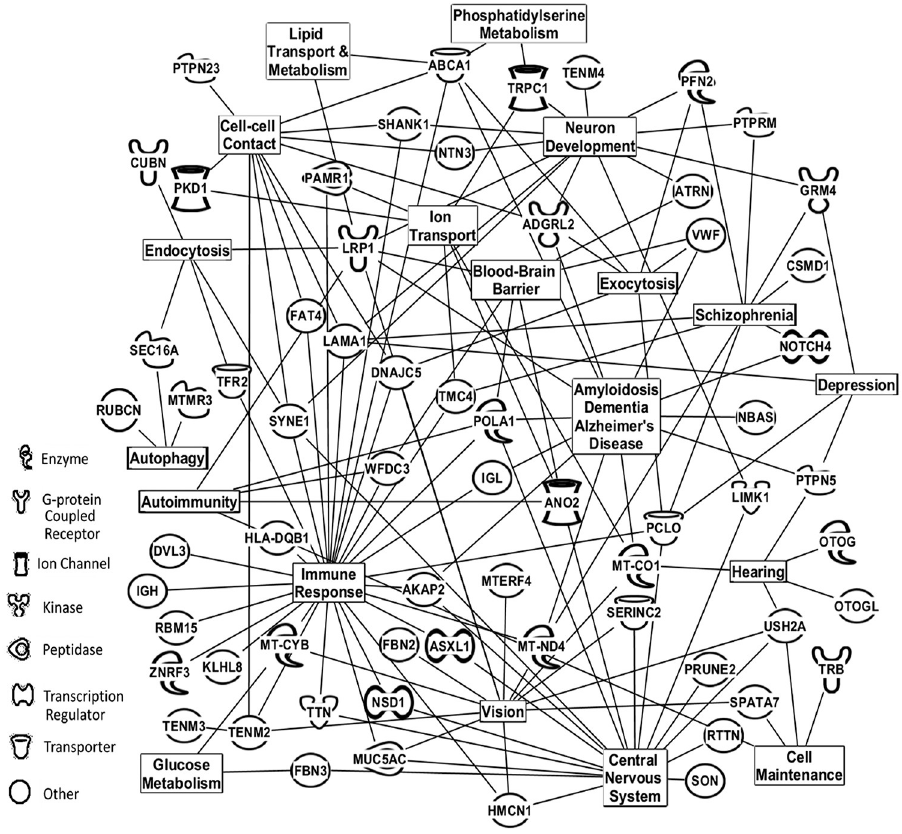
Fig 6. Physiological/cellular pathways of serum proteins found to distinguish TBI most affected patients from controls. Affected physiological/cellular pathways and serum protein assignments from Table 3 (top panel) that were found to distinguish TBI most affected patients from control individuals. The next top 58 proteins for each group (TBI most affected or control) not exhibited in Table 3 were added to the 48 in this table for this analysis. Analysis performed by using Ingenuity Pathway Analysis (IPA) bioinformatics software (Qiagen, Inc.). peak comparison dataset (e.g., peak 635, Fig 2 panel B). This midpoint is used to assign the group LOOCV classification for any “left out” peak in the LOOCV analysis. For example, if a “left out” samples identical m/Z peak has an area above this midpoint then that peak is classi- fied as the larger peak area class. In the case of peak 635 this would be the most affected classifi- cation; if the area is equal to or below this value the peak classification would be “control”. In this way a % of significantly changed mass peaks classified (e.g., as most affected) is assigned each “left out” sample and plotted on the y axis vs the individual serum samples on the x-axis (e.g., in Fig 3 panel A). Randomization of serum samples from subject groups compared in binary fashion (another method to assess data over-fitting) was obtained using the RAND function in Excel 2016 but retaining group number and age ratios [31]. Upon randomization, the identical mass peak LOOCV database was created and the same analysis described above was performed. To obtain potential statistical powers for group sample sizes (ability to detect type II errors-false negatives), Cohen’s d effect size values are calculated from the binary group % LOOCV means and standard deviations in Table 2 [32, 33]. Statistical power using given sample sizes is calculated as described [33]. S1–S19 Tables provide spectral data, pre-averaged raw values and MS/MS data. Processing step result values are in S16, S17, S18 and S19 Tables.